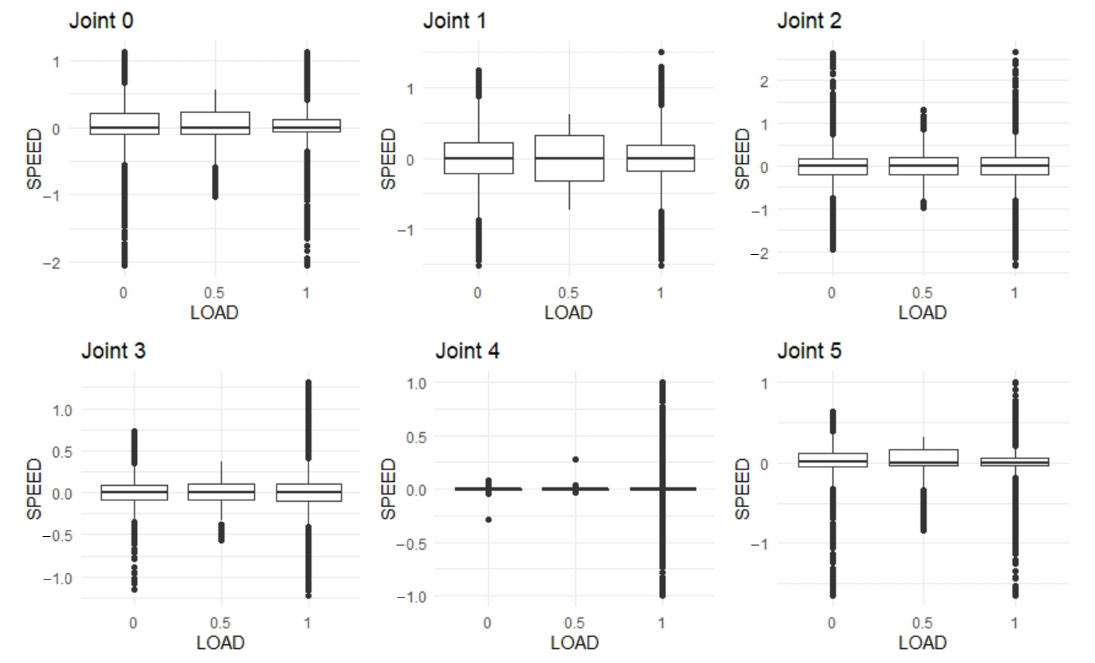
Figure 12. Box-plot of the Load with the